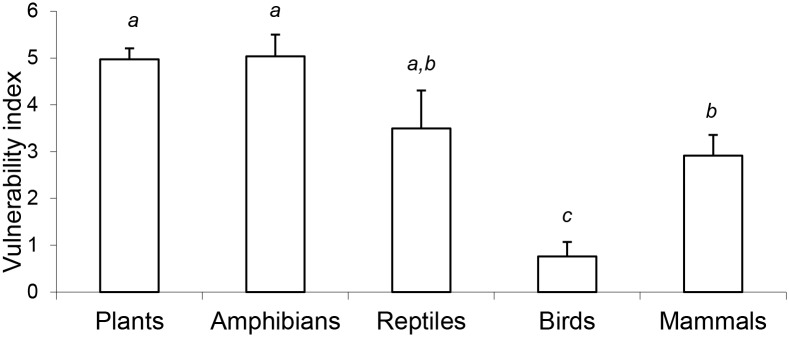
Mean climate change vulnerability for the five taxonomic groups of Australian threatened species considered in this study.Error bars represent 1 SE. Letters represent groups with no significant difference at a 95% CI, according to Tukey’s honestly significant difference test.